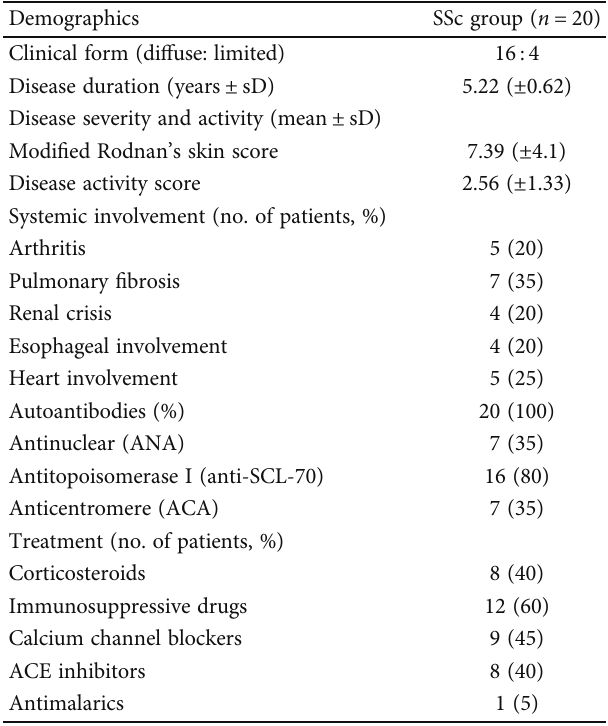
Table 1: Disease characteristics of individuals with systemic